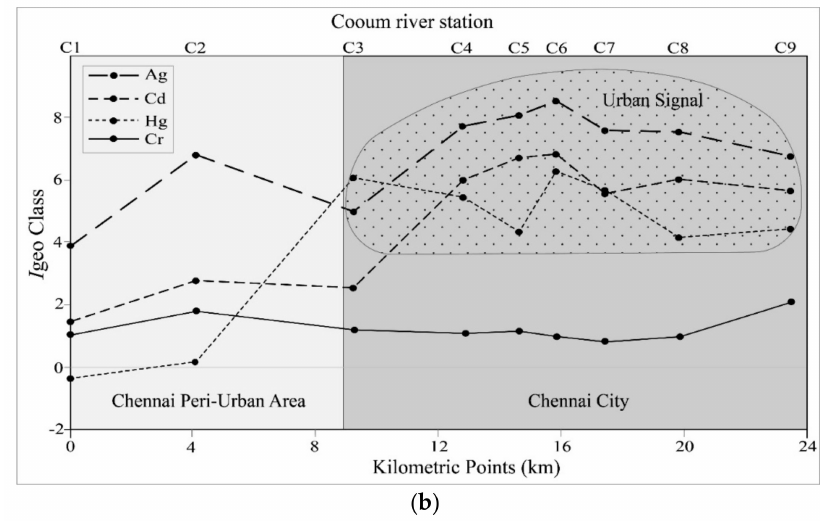
Figure 3. ( a ) Geoaccumulation Index ( I geo ) value of trace elements (Ag, Cd, Cr and Hg) in Adyar river sediments; ( b ) Geoaccumulation Index ( I geo ) value of trace elements (Ag, Cd, Cr and Hg) in Cooum river sediments.